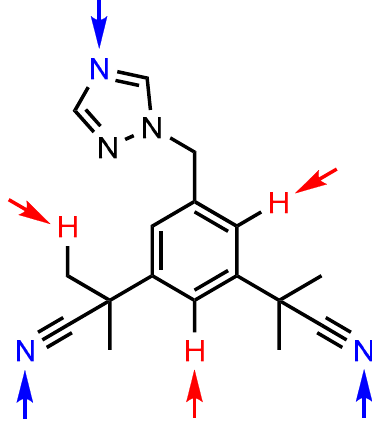
Figure 1. Structure of anastrozole with assigned hydrogen bond donor (red) and hydrogen bond acceptor centers (blue) found in its crystal structure (SATHOL) [20].